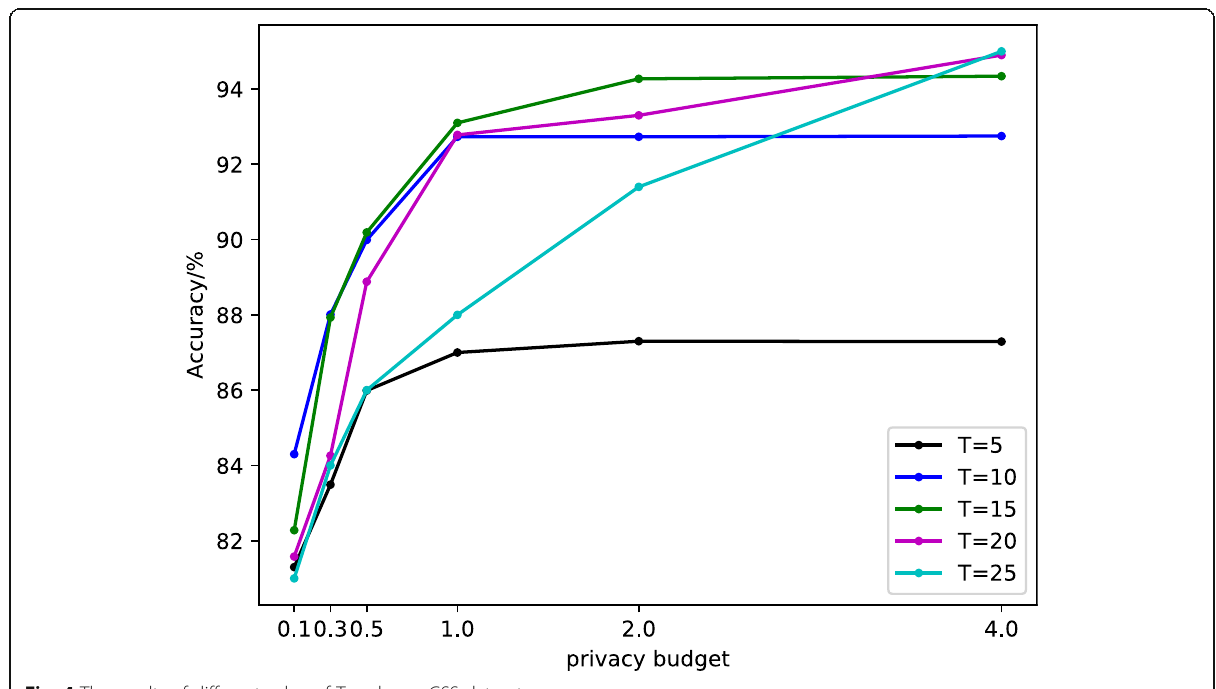
Fig. 4 The results of different value of T and ε on GSS dataset